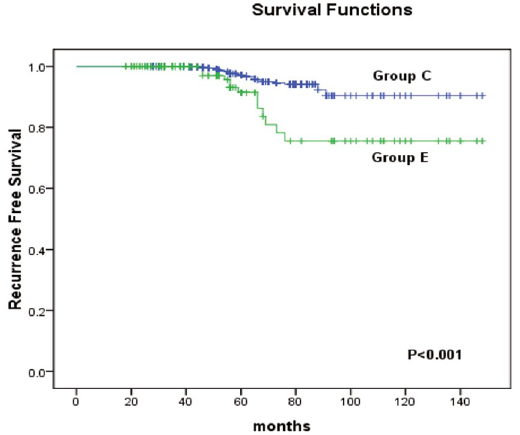
Figure 3. Kaplan-Meier analysis of recurrence-free survival of unifocal papillary thyroid cancer with a diameter of ≤ 1 cm (group C) and multifocal papillary thyroid microcarcinoma with a total tumour diameter (TTD) of > 1 cm (group E).